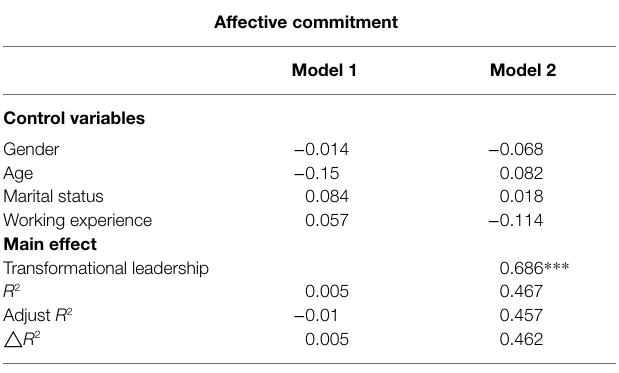
TABLE 8 | Moderating effect of job insecurity in transformational leadership and affective commitment.